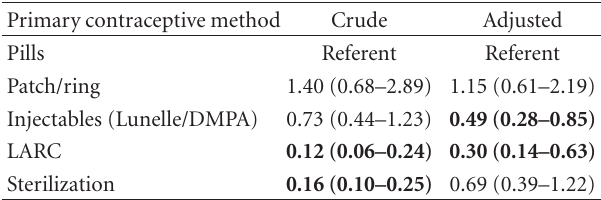
Table 4: Association of primary contraceptive method with dual- method